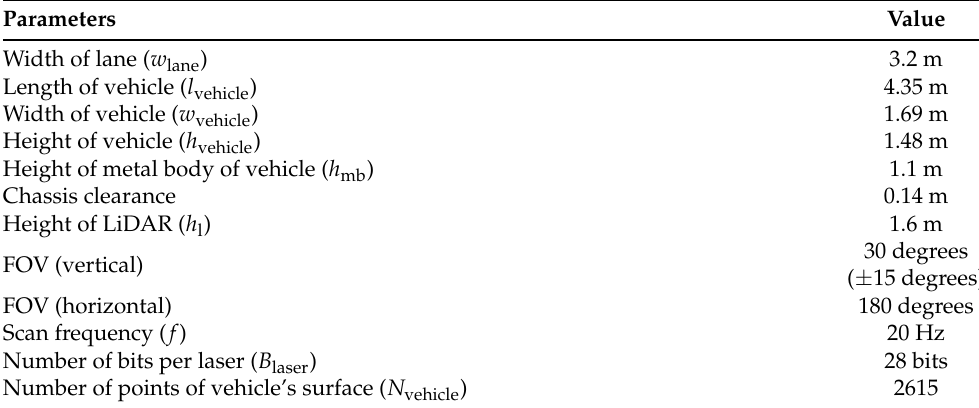
Table 1. Simulation parameters for LiDAR detection.